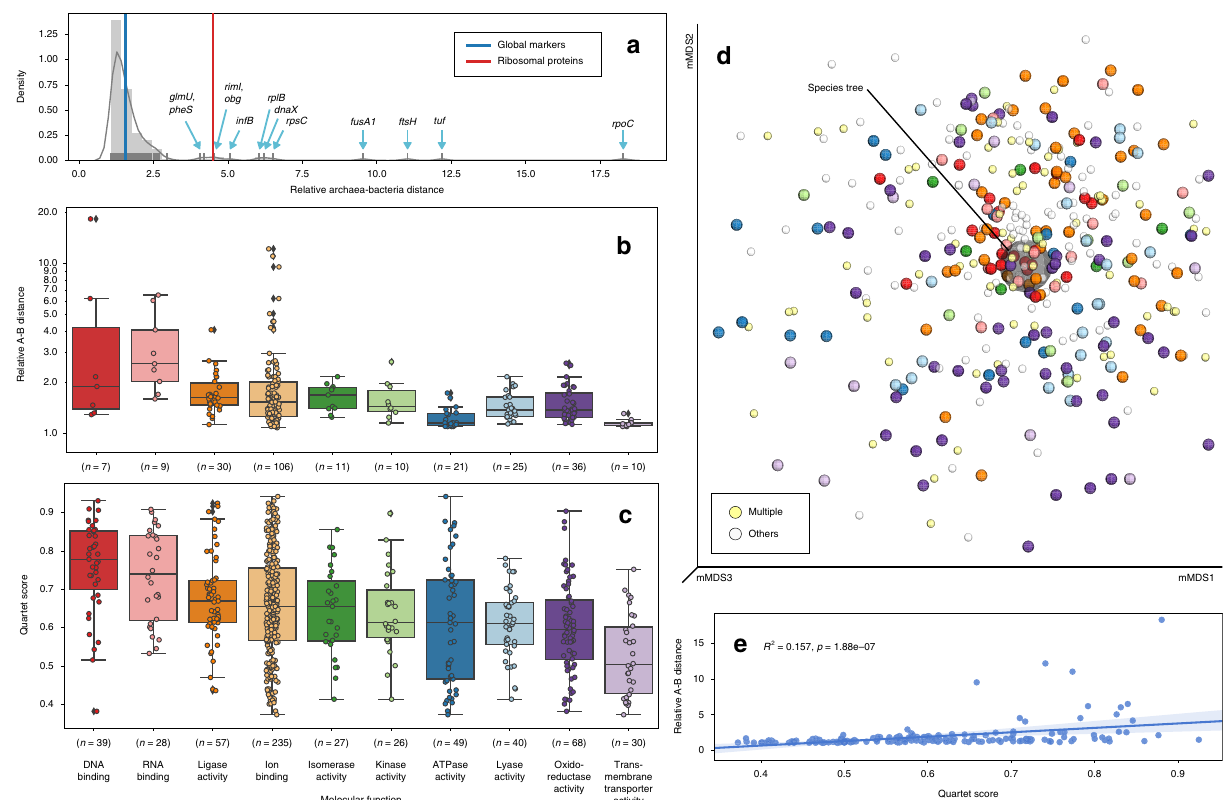
Fig. 5 Relative Archaea – Bacteria distances indicated by individual gene trees and their concordance with the species tree. a Distribution of relative A (rchaea) – B(acteria) distances of individual gene trees. A total of 161 gene trees are shown, selected such that both domains have at least 50% taxa represented in each tree. A histogram with Gaussian kernel density function and a rug plot representing individual data points are displayed. The blue and red vertical lines indicate the values of the ASTRAL species tree with branch lengths estimated using the global markers and the ribosomal proteins, respectively. Gene names are labeled at data points separated from the main cluster. b Distribution of relative A – B distances by functional category (GO slim term under the “ molecular function ” master category) of the 161 gene trees. The top ten most frequently assigned categories in all gene trees are shown. Boxplot components: center line, median; box limits, upper and lower quartiles; whiskers, 1.5 × interquartile range; black diamonds, outliers. c Distribution of quartet scores of all 381 gene trees vs. the species tree. Boxplot components are identical to b . d mMDS plot of the quartet distance matrix of all 381 gene trees plus the species tree (semi-transparent big gray ball in the center). The color scheme for genes annotated by exactly one of the top ten functional categories (normal-sized balls) is consistent with b and c , except that the category “ ion binding ” is omitted due to its high frequency. Genes annotated by more than one of the top ten categories (light yellow), or by categories other than the top ten (semi-transparent light gray) are indicated by smaller balls. e Linear regression of relative A – B distances vs. quartet scores of the 161 gene trees. The squared Pearson correlation coef fi cient ( R 2 ) and two-tailed p -value are displayed. Source data are provided as a Source Data fi